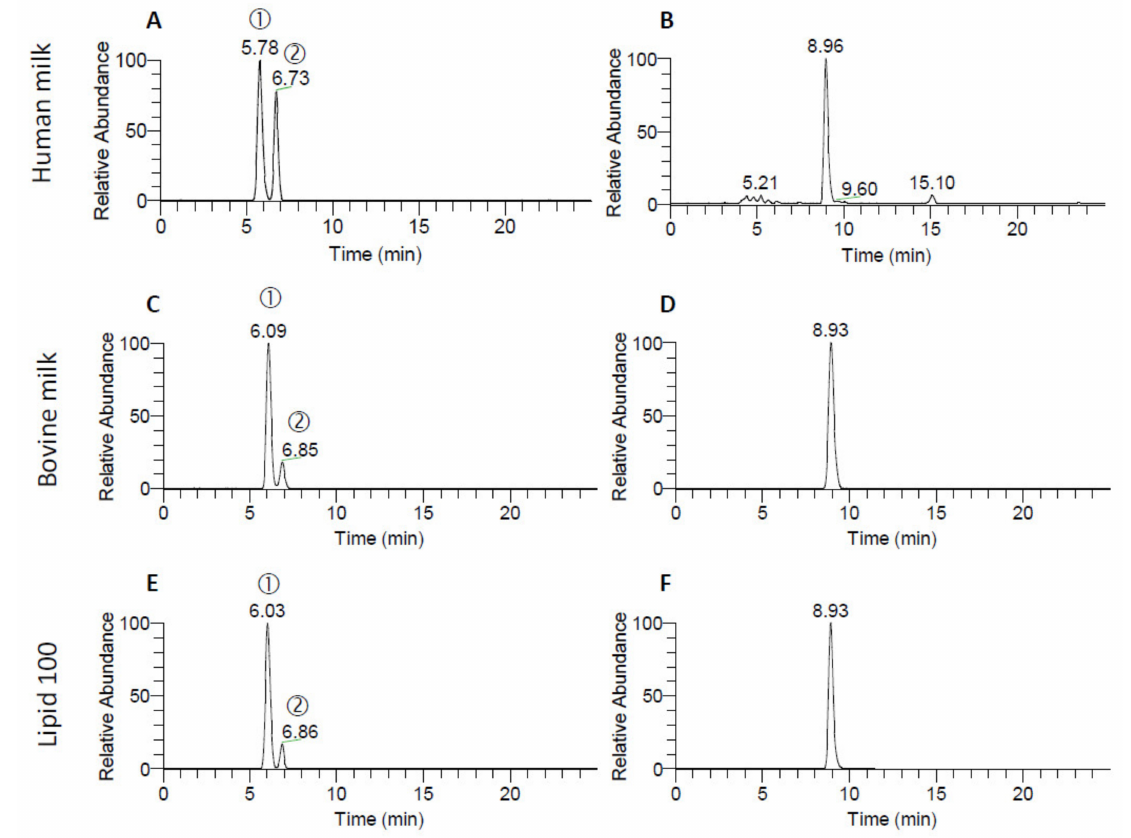
Figure 3. TICs of the HILIC separation of Crb ( A ) and LacCer ( B ) for human milk, bovine milk ( C , D ) and MFGM Lipid 100 ( E , F ). The first and second Crb peaks in each sample ( A , C , E ) are labeled as 1 (cid:79) and 2 (cid:79) ,